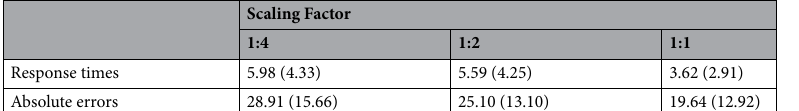
Table 2. Mean absolute errors (in mm), and response times (in s) as a function of scaling factor (1:4, 1:2, 1:1). Standard deviations are presented in parentheses.